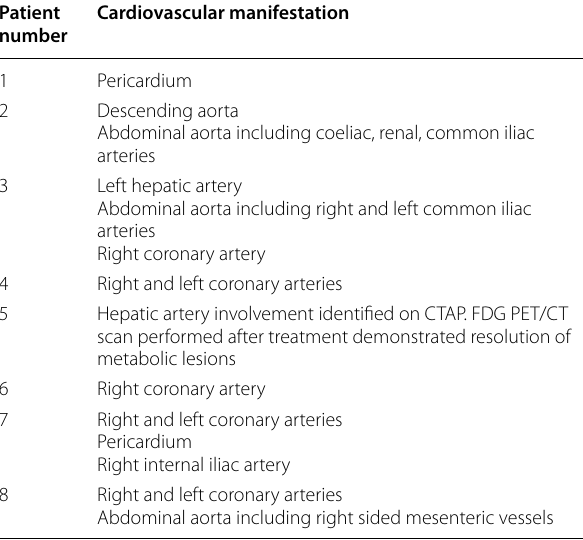
Table 3 Cardiovascular manifestations of IgG4‑related disease